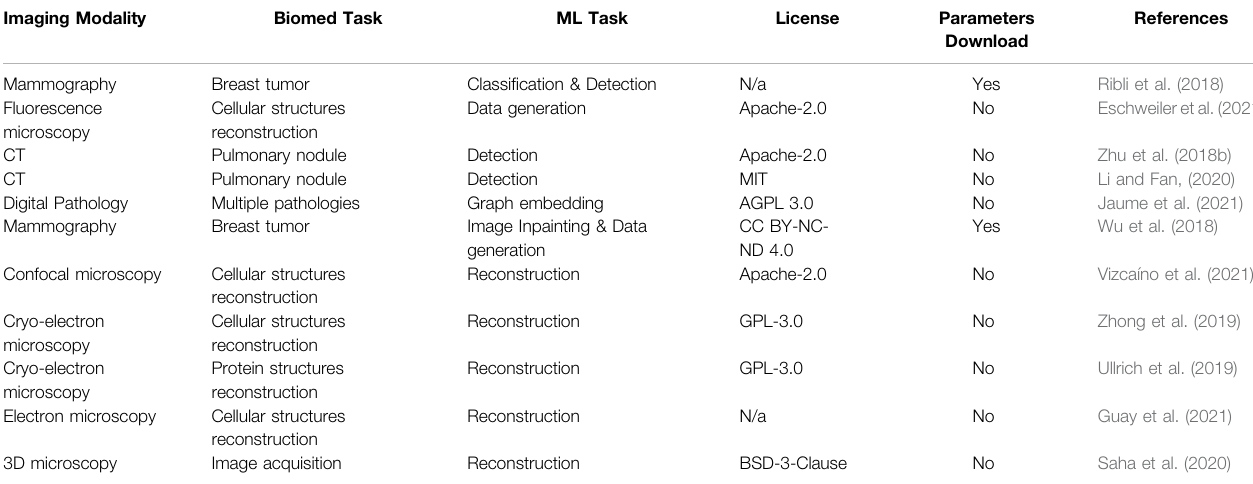
TABLE 3 | Other Biomedical Image Models. Here, CT is computed